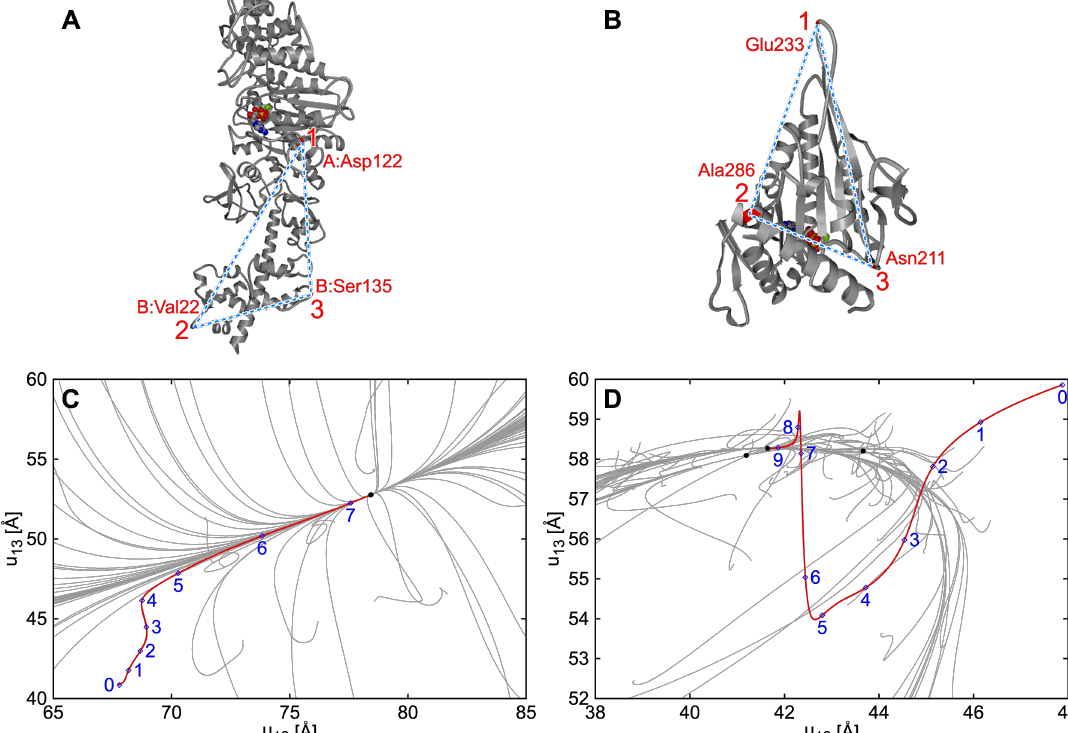
Figure 2. Relaxation paths of ENMs. Two molecular motors were compared: ( A , C ) Myosin V and ( B , D ) KIF1A; ( A , B ) Structure of the motors; positions of the markers 1,2,3 are shown. The ATP-bound structure of myosin V and ADP-bound structure of KIF1A were used as the reference structures to construct the ENMs; ( C , D ) Trajectories of conformational changes. Horizontal and vertical axes show the distances between markers 1 and 2, and markers 1 and 3, respectively. Gray lines display trajectories starting from 100 different initial deformations, prepared by applying static force toward random direction to each particle. In most cases, these trajectories quickly converge to an energetic valley (represented by a bundle of trajectories in ( C , D )), and slowly return to the reference structure (stable state). This behavior is common for these two motors, and the direction of the valley around the reference structure agrees with the slowest normal mode. Red lines represent transitions between two states of the motors, which start from the nucleotide free state of myosin V (i.e., corresponding to the conformational transition upon ATP binding), and from the ATP-bound state of KIF1A (i.e., corresponding to the transition from the ATP-bound state to the ADP-bound state); label 0 shows the initial condition and the relaxation proceeded 1, 2, · · · . In myosin V, the trajectory was similar to those from random deformations, and the normal mode approximation holds well except for initial changes. In KIF1A, in contrast, the relaxation progressed with multiple steps, and the trajectory converged to the slowest normal mode direction only at the final stage of relaxation (<1 Å of distance change). Reproduced from [61] with